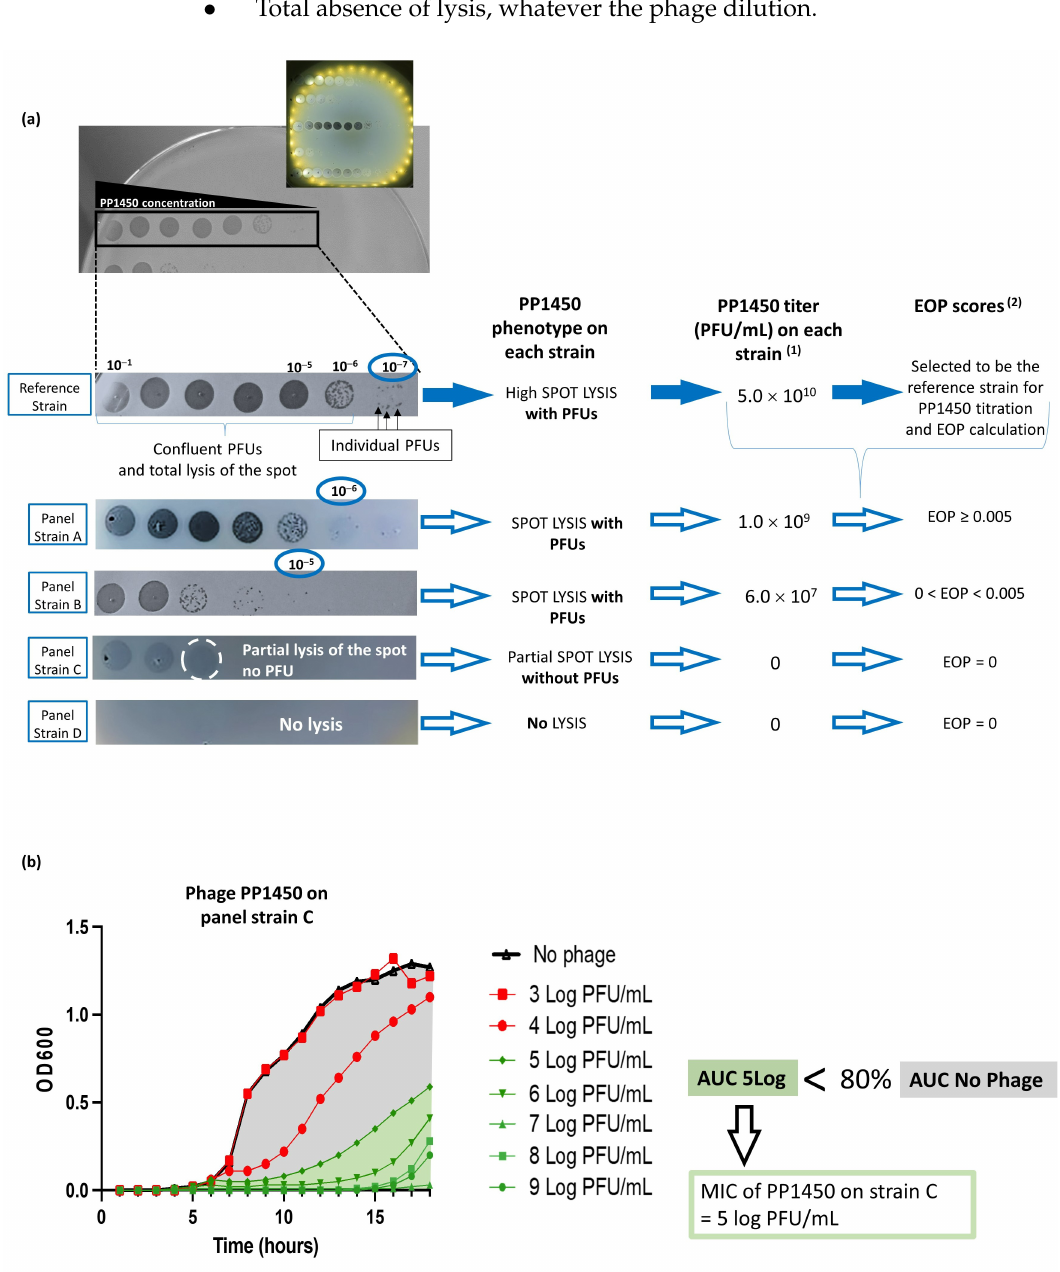
Figure 1. Phage activity testing methods. ( a ) Spot plaque assay method for titration and efficiency of plating (EOP) determination. PFU stands for plaque forming unit or lysis plaque. (1) titer was calculated as follows: with the reference strain: titer = number of PFU in one spot (25)/[V phage (0.005) × Dilution factor (10 − 7 )]; with the strain A: titer = number of PFU in one spot (5)/[V phage (0.005) × Dilution factor (10 − 6 )]; with the strain B: titer = number of PFU in one spot (3)/[V